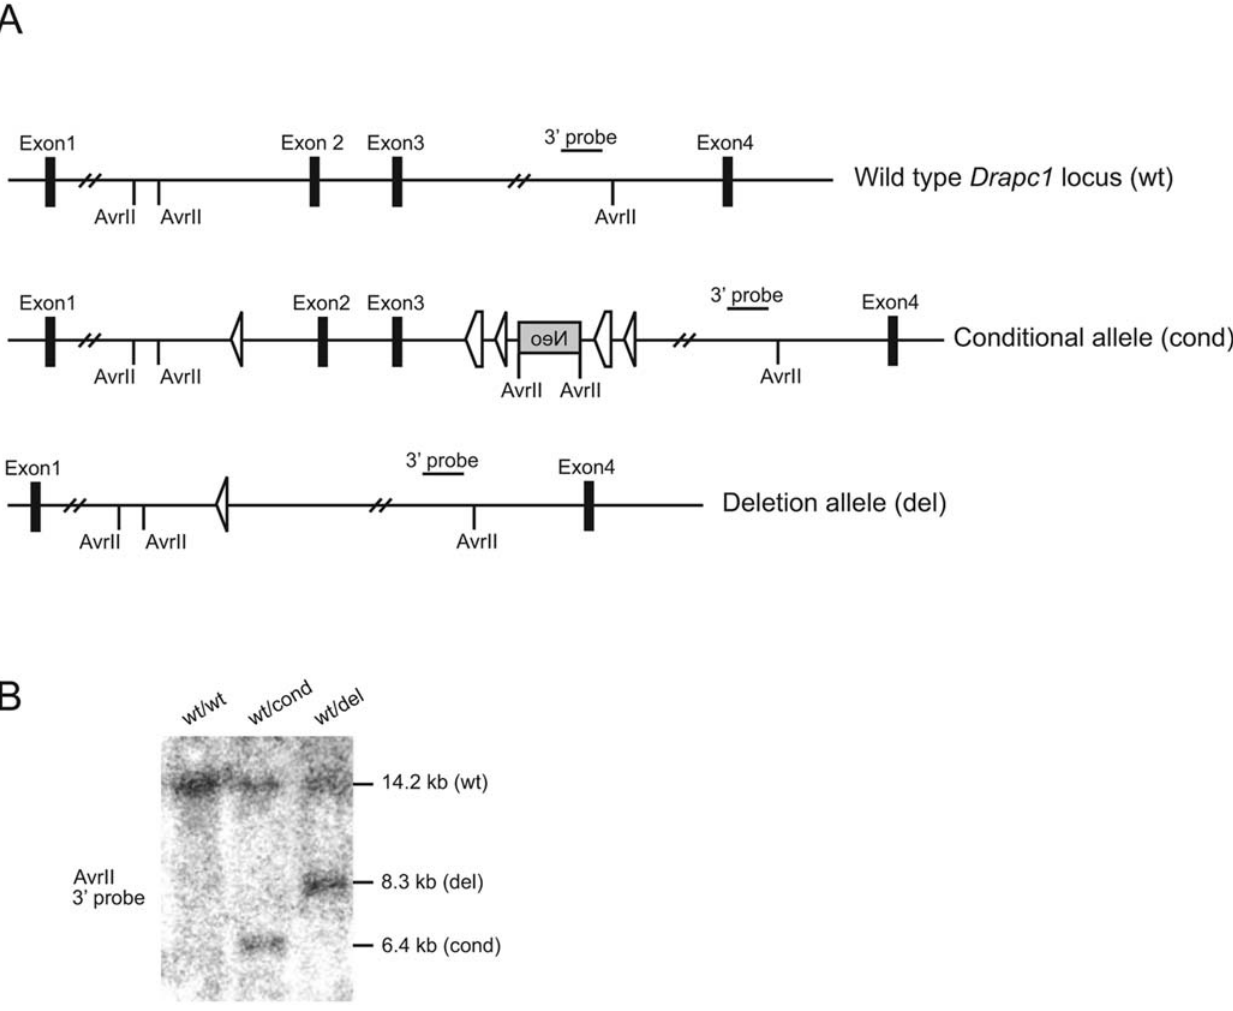
Figure 8. Comparison of wild type, conditional, and deletion alleles of the mouse Drapc1 locus. ( A ) A schematic of wild-type (wt), conditional (cond), and Cre-recombined (del) Drapc1 alleles. ( B ) Southern blot analysis of DNA isolated from the tails of mice carrying different Drapc1 alleles (AvrII digestion), with the 3 9 probe illustrating the 14.2 kb wild type (wt), 6.4 kb conditional (cond), and 8.3 kb deletion (del) alleles.